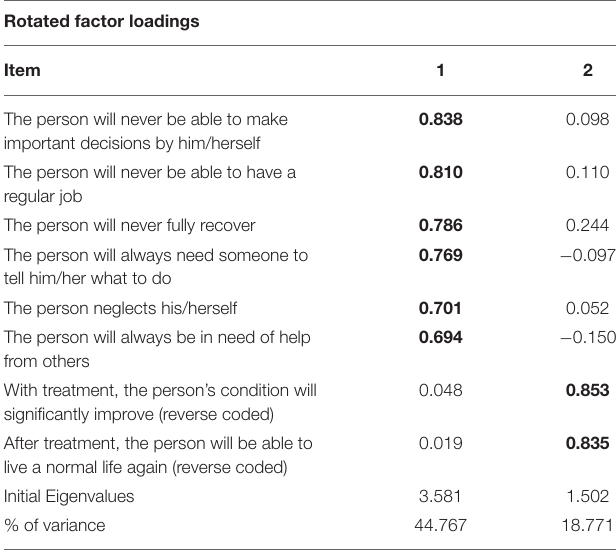
TABLE 2 | Summary of exploratory factor analysis results for illness course